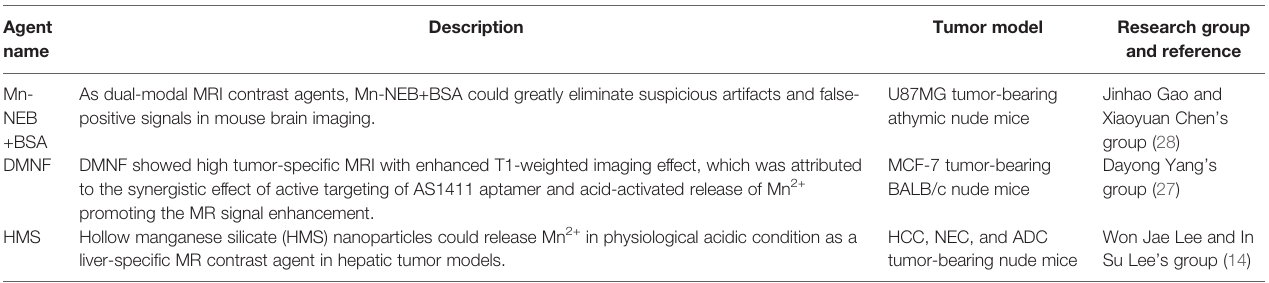
TABLE 1 | Manganese-based hybrid nanomaterials as imaging